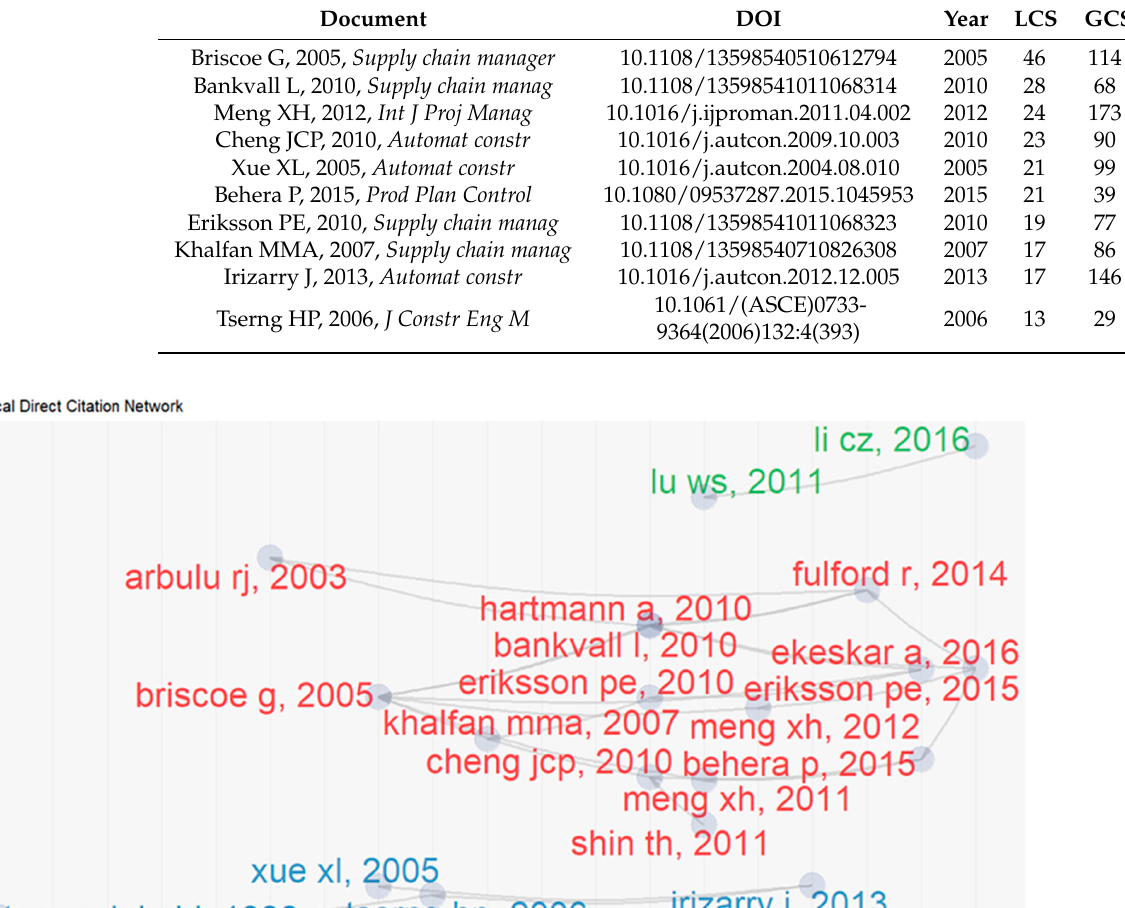
Table 1. Local citation score (LCS) and global citation score (GCS) in construction supply chain management (CSCM) research.